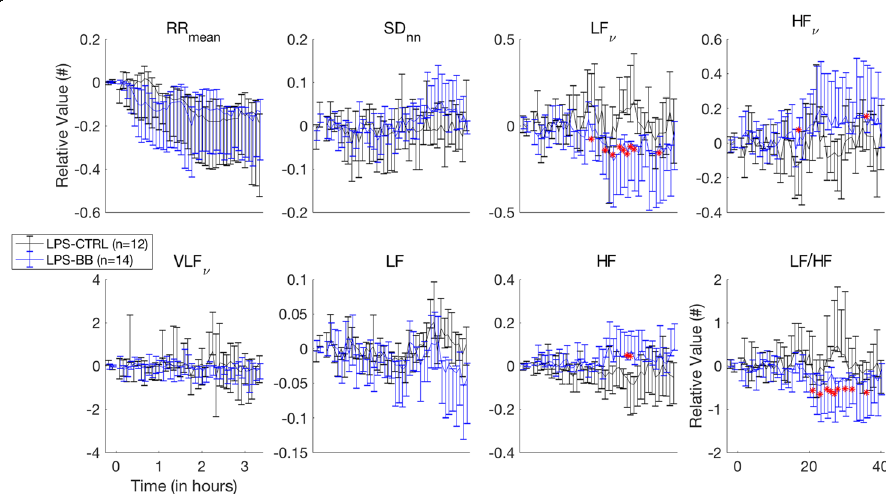
Fig. 5 Temporal and spectral evolution in LPS-BB/LPS-CTRL groups. Evolution of temporal and spectral parameters over the course of the experiment ( t = 0 to 3 h) for LPS-BB (blue) and LPS-CTRL (black) groups: each point represent a 5-min sample from which the median and interquartile ranges are derived and indicated with error bars. There appears to be a trend towards increasing SD in the LPS-BB group. Spectral analyses show a drop in spectral power for the LF band as it increases for the HF band. This is characterized by a clear decrease in values for the HFLF ratio for the LPS-BB group compared to the LPS-CTRL